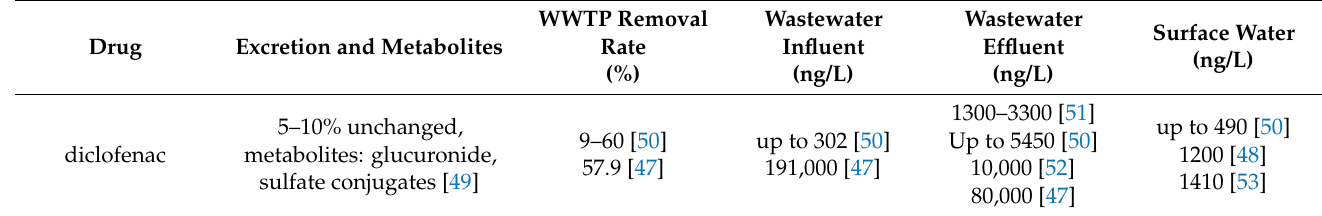
Table 1. The concentrations and removal rates of painkillers in the environmental